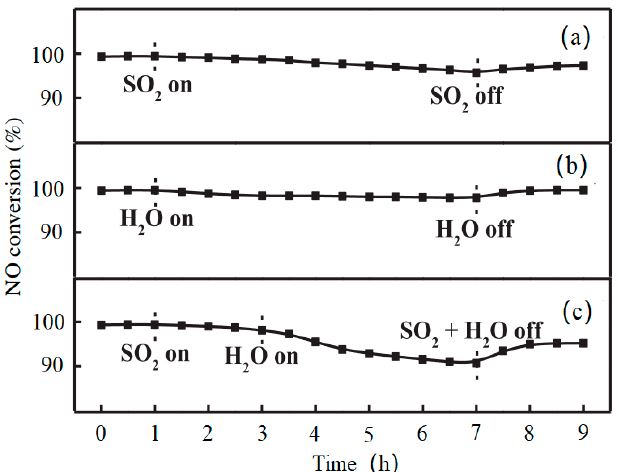
Figure 4. Effect of ( a ) SO 2 , ( b ) H 2 O and ( c ) SO 2 + H 2 O on NH 3 -SCR activity over Ce 0.5 Ti 0.5 catalyst at 300 °C. Conditions: [NH 3 ] = [NO] = 1000 ppm, [SO 2 ] = 100 ppm, [H 2 O] = 10 vol.%, [O 2 ] = 3 vol.%, N 2 as balance gas [39].